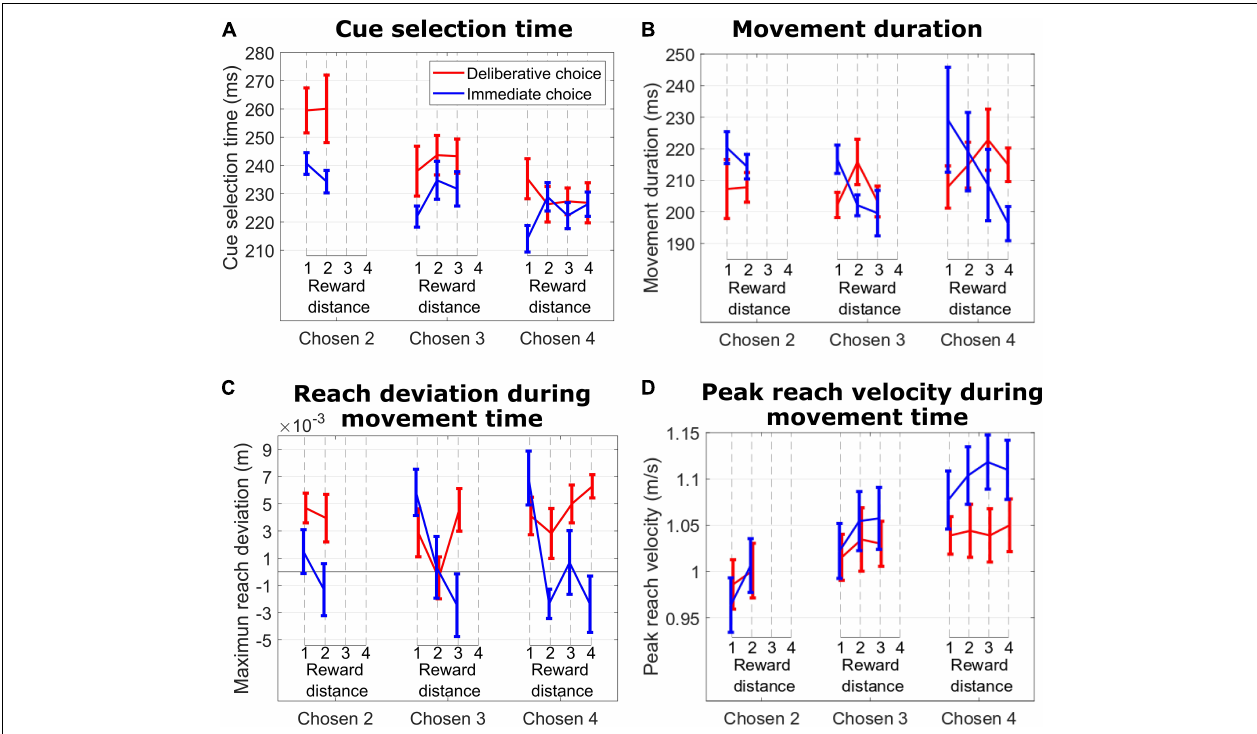
FIGURE 4 | (A) Cue selection time vs. reward distance (RD) between cues for different Chosen Values for DC (red curves) and IC (blue curves) trials during the hand tracking sessions with subject M1. (B) Same format as in (A) for movement duration. (C) Same format as in B for maximum reach deviation. (D) Same format as in (C) for peak reach